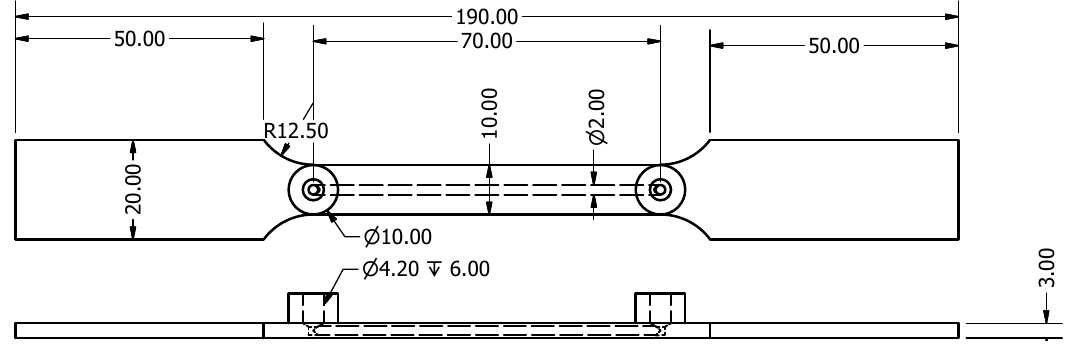
Figure 1. Tensile test sample dimensions (in mm).